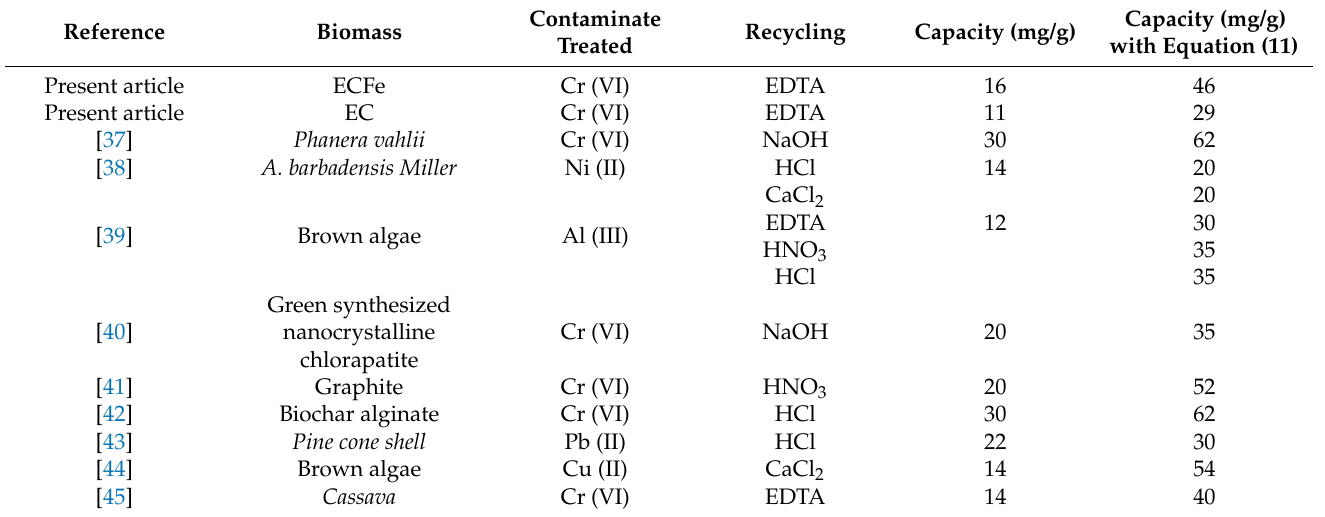
Table 10. Researchers of the process of desorption.